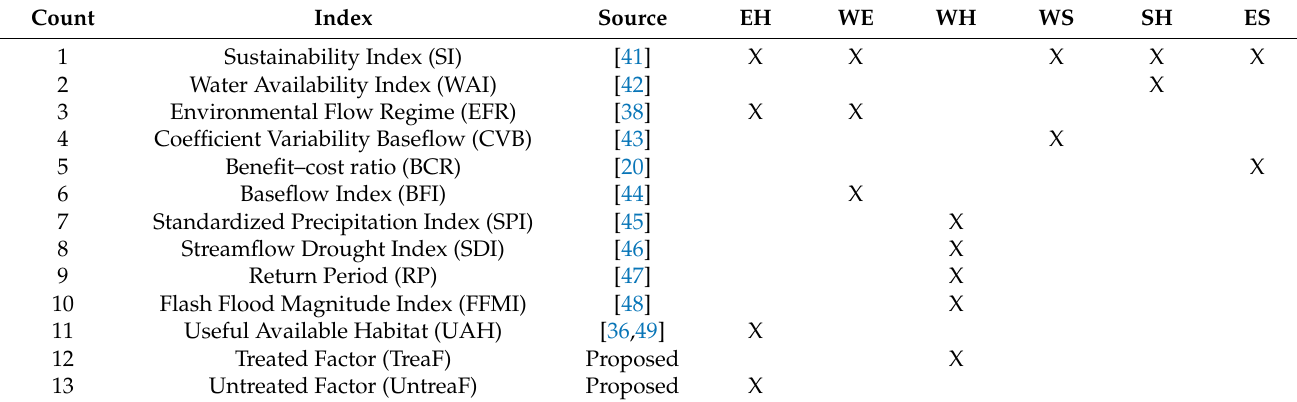
Table 3. List of indices that were used to calculate the WGP axes. Source: own